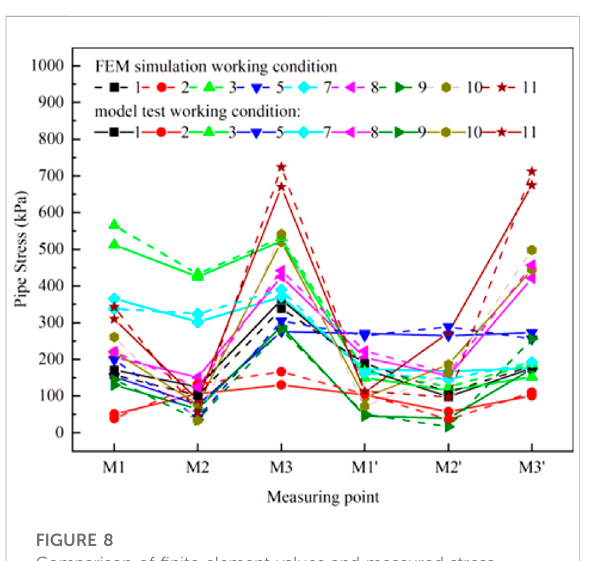
FIGURE 8 Comparison of fi nite element values and measured stress values.